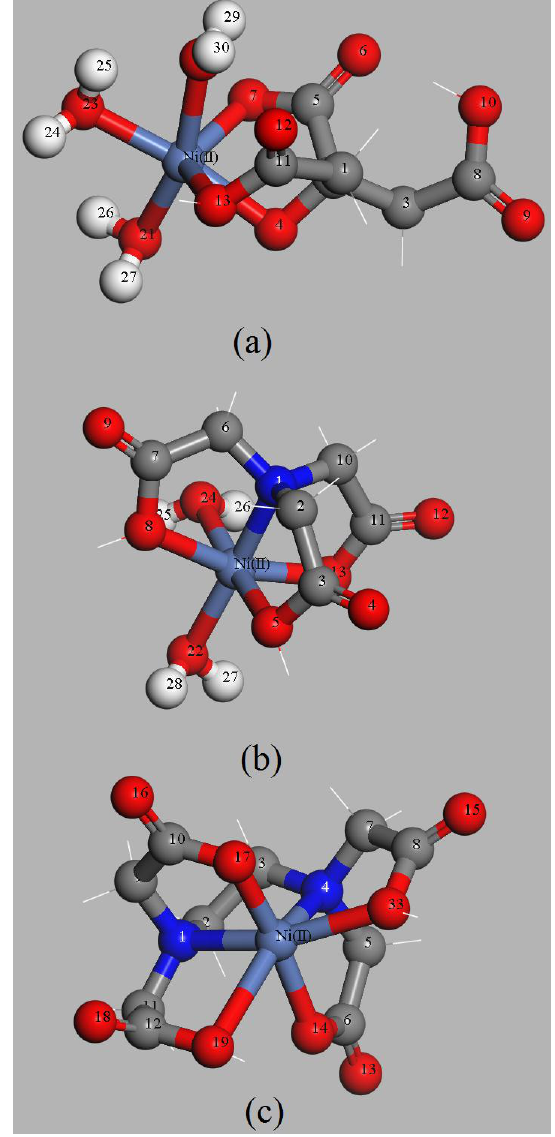
Figure 10. Optimized structures of [Ni(II)-citrate] + , [Ni(II)-NTA] + and [Ni(II)-EDTA] 0 complexes with the numbered atoms: numbered atoms are denoted as follows: ( a ) [Ni(II)-citrate] + (24–27, 29, 30,